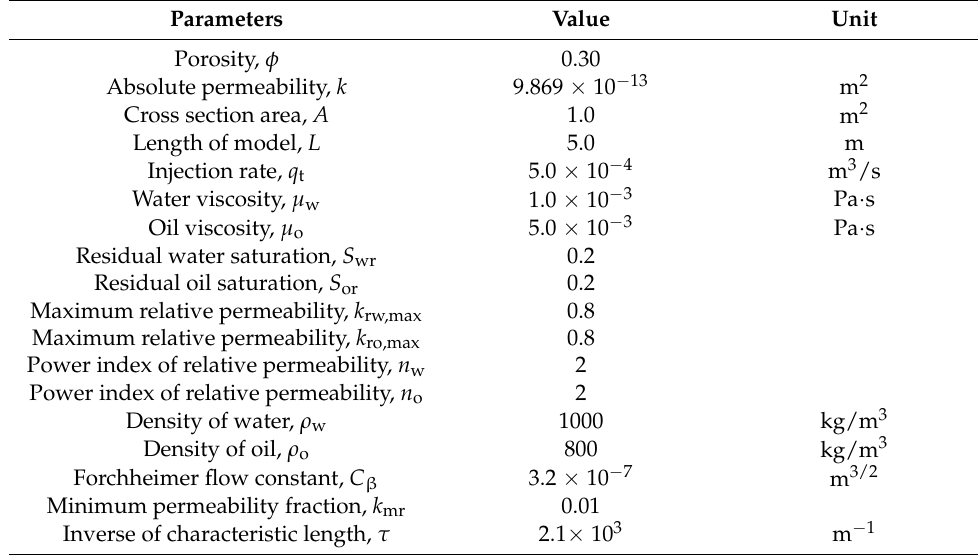
Table 1. Parameters for physical flow